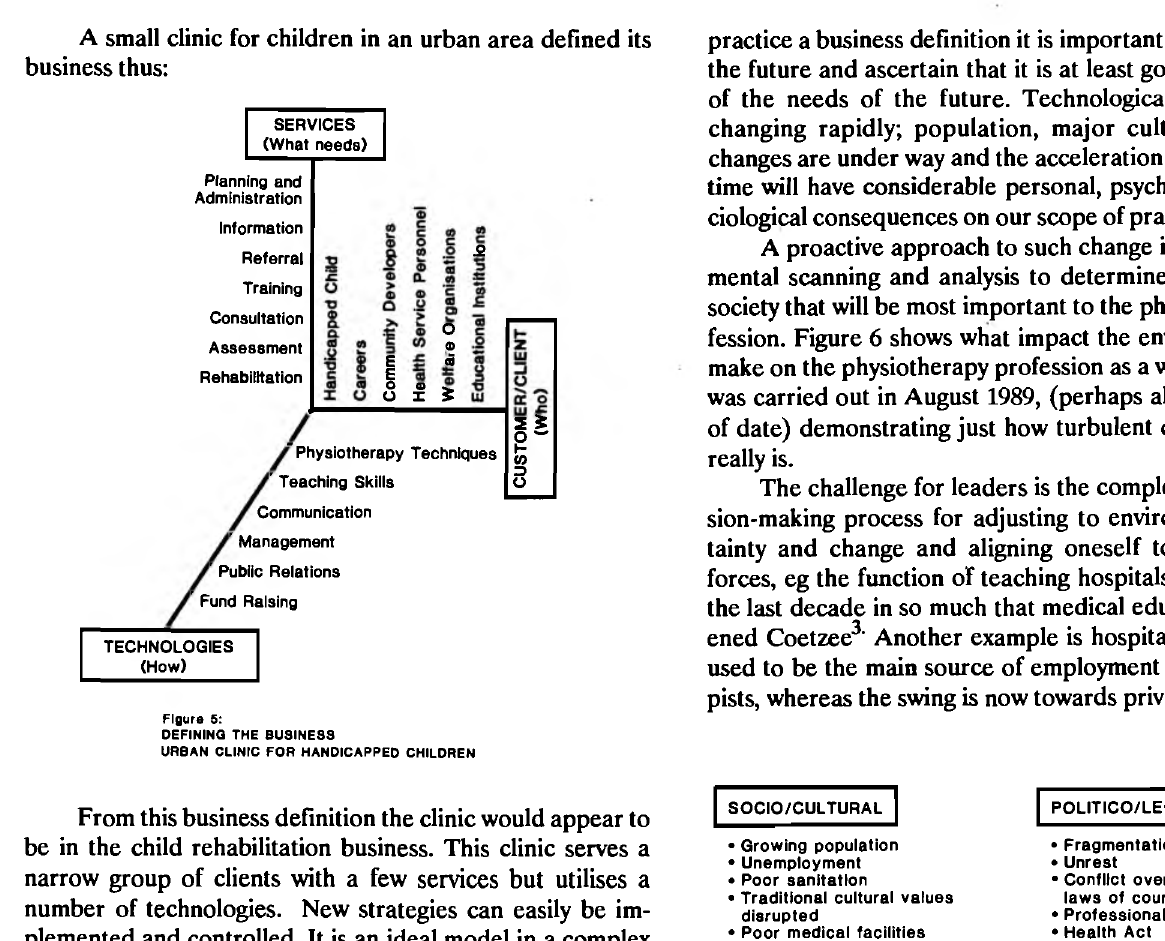
Figure 7: ENVIRONMENTAL ANALYSIS : URBAN CLINIC FOR HANDICAPPED CHILDREN